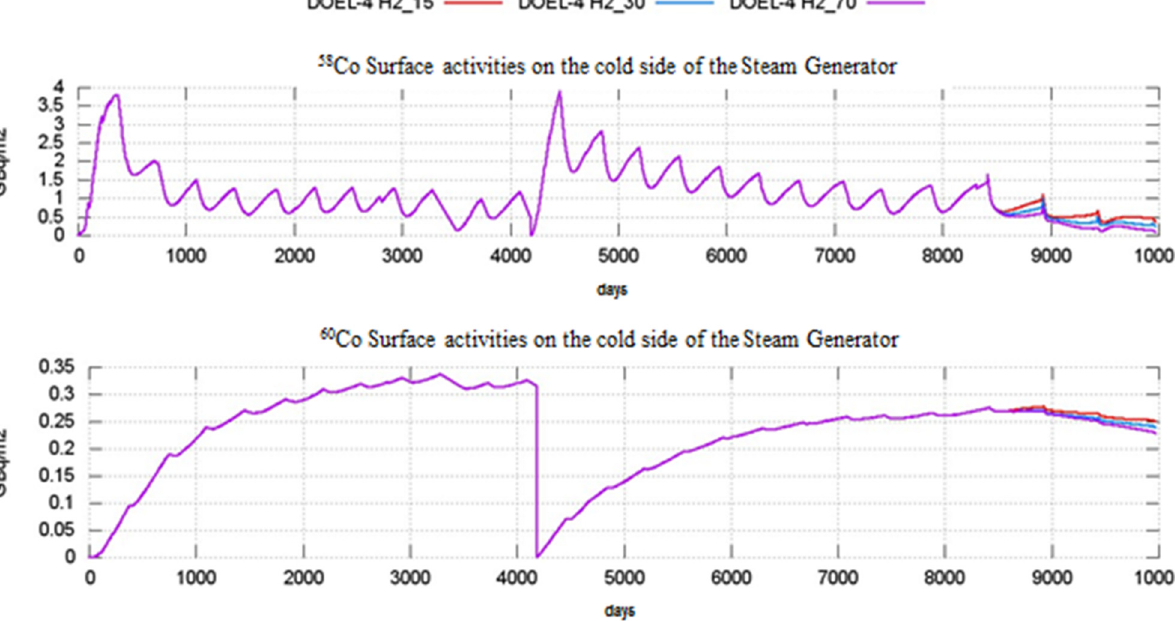
Fig. 7. OSCAR V1.3 calculation (cid:2) Surface activities on the cold side of the steam generator tubing region of